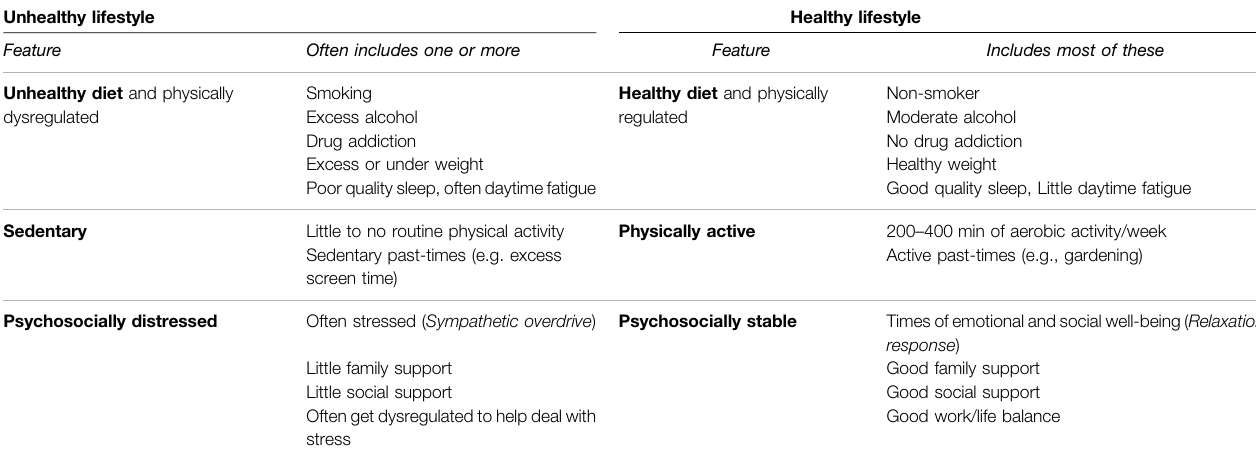
TABLE 1 | Features of unhealthy and healthy